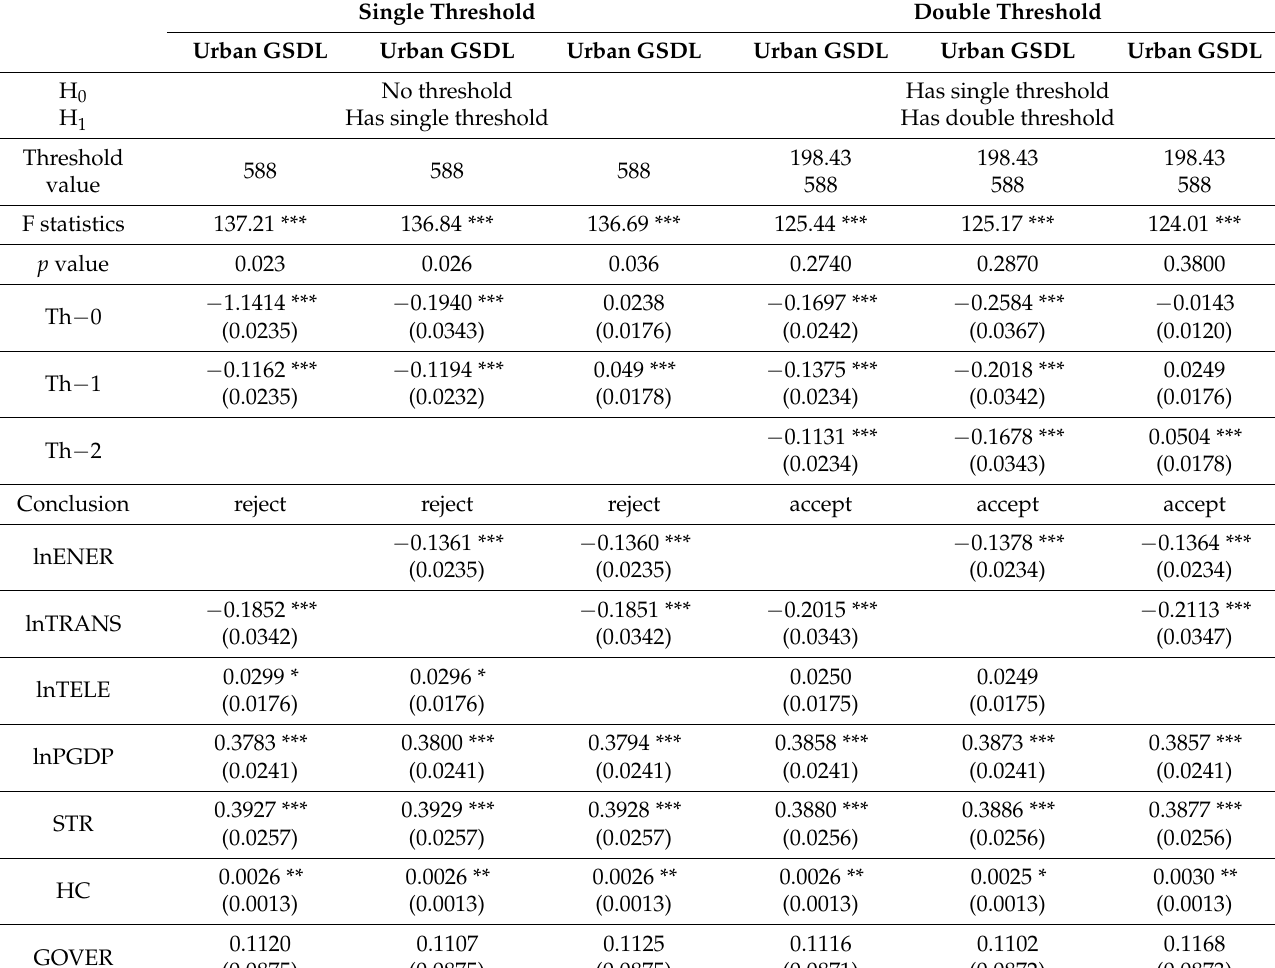
Table 6. Threshold effect